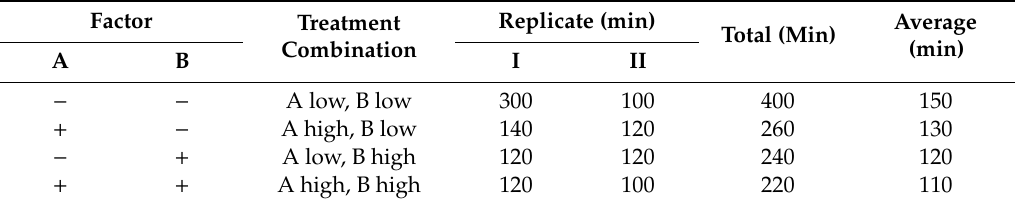
Table 4. 2 2 factorial design with cooling time as response